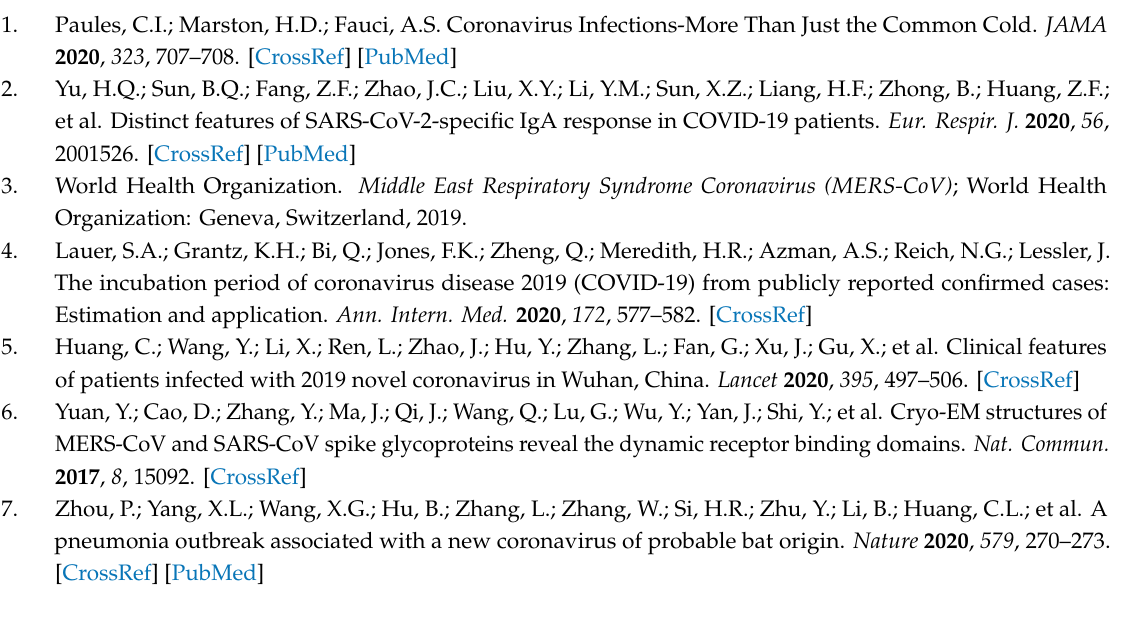
Table S1: Studies concerning COVID-19 e ff ects on the Central Nervous System; Table S2: Studies concerning COVID-19 e ff ects on the Peripheral Nervous